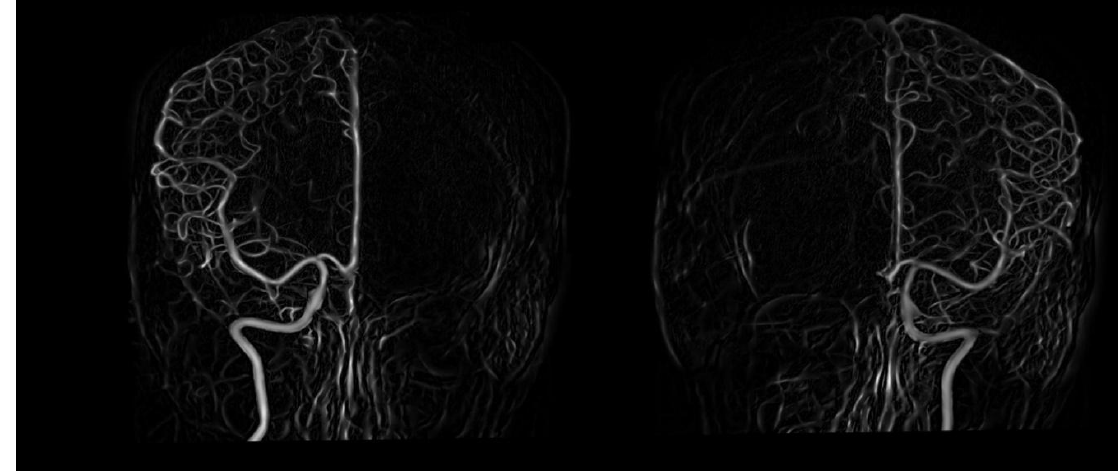
Figure 4. Sample of DSA scans after performing preprocessing.